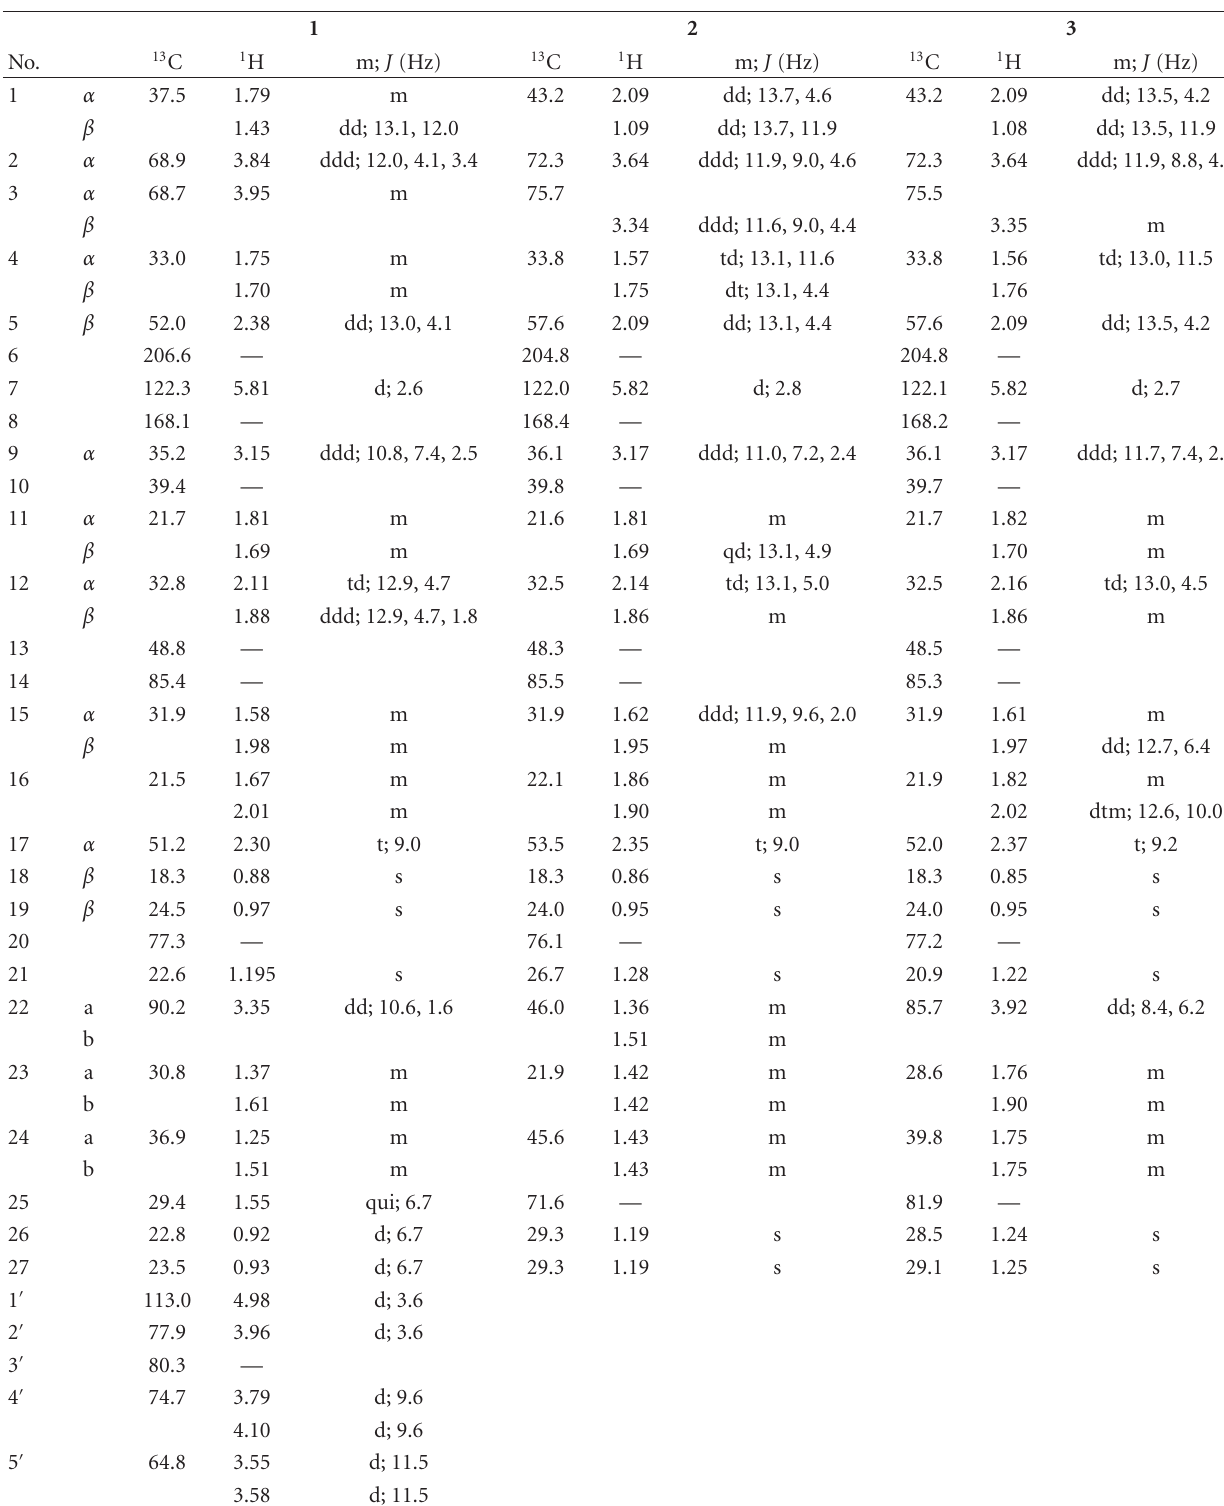
Table 1: 1 H and 13 C NMR data of 1 , 2 , and 3